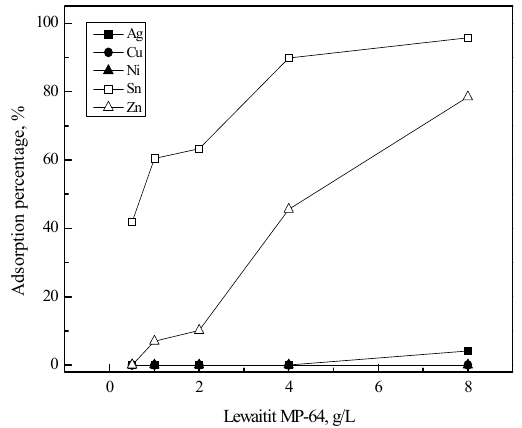
Figure 5. Effect of Lewaitit MP-64 concentration on the adsorption of metals in 5 M HCl solution. [Lewaitit MP-64] = 0.5–8 (g/L), time = 6 h, shaking speed = 200 rpm.